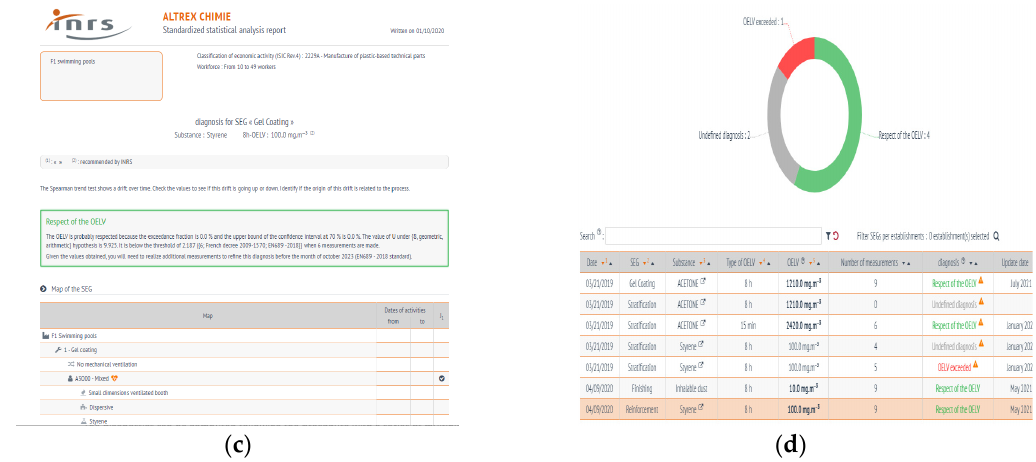
Figure 4. Assessing exposure during the making of swimming pools with AltrexChimie. On the top ( a ), the cartography and the task based SEGs. On the top ( b ), example of measurement data series related to gel coating SEG. On the bottom ( c ), an example of the report containing the exposure diagnostic and the statistical indicators of styrene measurements for the same SEG. On the bottom ( d ), the produced dashboards for all four SEGs and the different substances.